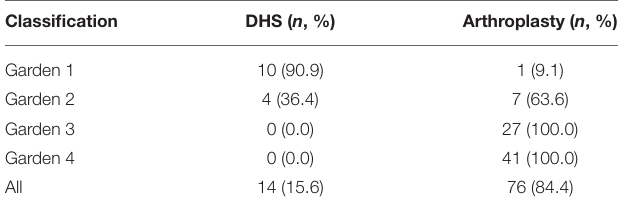
TABLE 3 | Operative procedure of femoral neck fractures depending on the Garden classification. Classification DHS ( n , %)